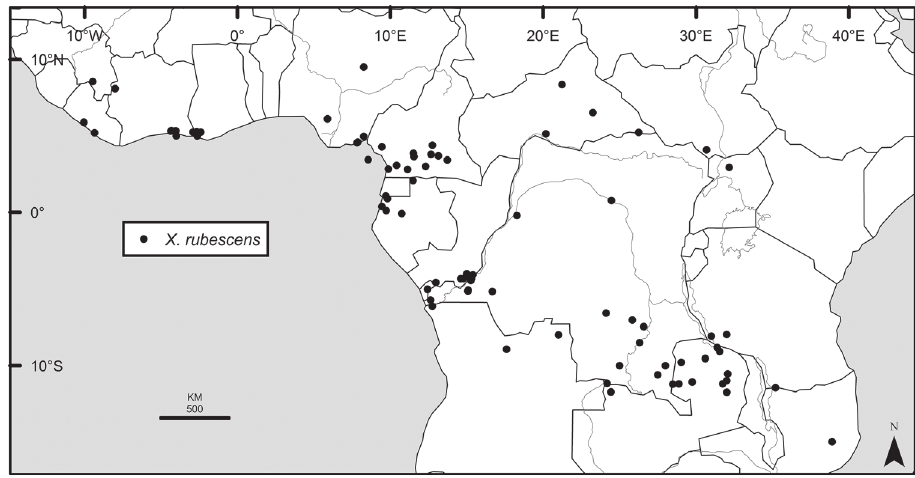
Figure 12. Distribution of Xylopia rubescens . Bolder lines represent country borders, fainter lines lakes and major